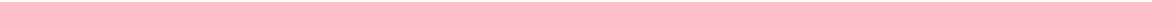
Fig. 2 Phenotypes of iDUX4pA mice in the basal “ off ” state. a Weekly average of the weight of iDUX4 and wild type ( WT ) male and female siblings ( n = 3 – 25). b Normalized mass to the body weight ( BW ) of various muscles in iDUX4pA males. Extensor digitorum longus (EDL ), tibialis anterior ( TA ), gastrocnemius and soleus ( G / S ), quadriceps ( Quad ), triceps brachii ( Triceps ), pectoralis, psoas major ( Psoas ), and masseter from 10 to 15 week old mice and age-matched siblings are analyzed ( n = 10). c Representative example of hanging wire, grip strength and rotarod analyses of 6-week-old iDUX4pA male and female mice ( n = 4). d Speci fi c force, time to reach peak twitch force ( TPT ) and time to reach 1/2 relaxation during twitch (1/2 TPT) of EDL in 6 – 10-week-old iDUX4pA males and age-matched siblings ( n = 8). e Representative FACS analyses for Lin neg (CD45 neg ; CD31 neg ) and PDGFR α + or Sca1 + cells in muscle from iDUX4pA males and sibling controls. Percent of PDGFR α + or Sca1 + cells in pooled muscle digests comprising TA, gastrocnemius, soleus, quadriceps, pectoralis, and triceps is shown at right ( n = 7). f RTqPCR analyses for DUX4 , DUX4 targets, myogenic genes, and genes involved in fi brosis in pectoralis from iDUX4pA male mice. Results are presented as fold difference to GAPDH ( n = 4). g Auditory brainstem response ( ABR ) in iDUX4 males, females and WT sibling controls ( n = 5, 6 – 8 week old mice). Note that iDUX4pA males do not respond to sounds of 16 kHz and above and iDUX4pA females to sounds of 32 kHz. All data are presented as mean ± SEM; * p < 0.05, ** p < 0.01, *** p < 0.001, **** p < 0.0001 by T -test or g